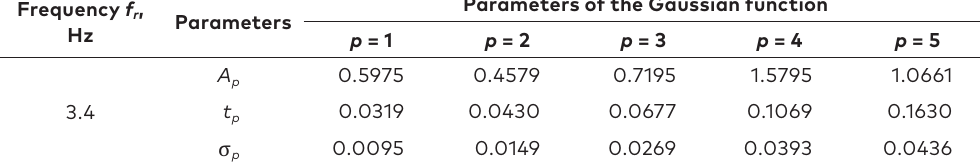
Table 9. Parameters of the template for running frequency of 3.4 Hz Frequency f r , Hz